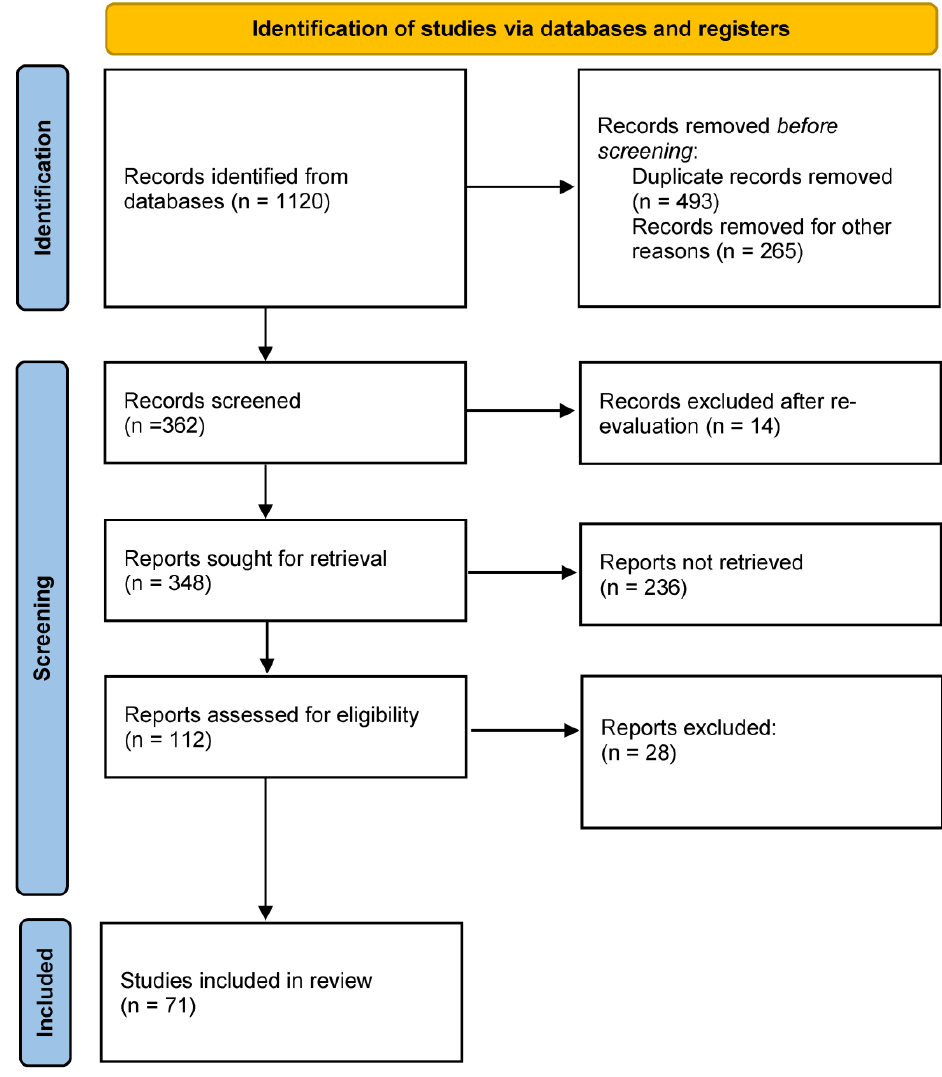
Figure 2. Process of identification and inclusion of studies.